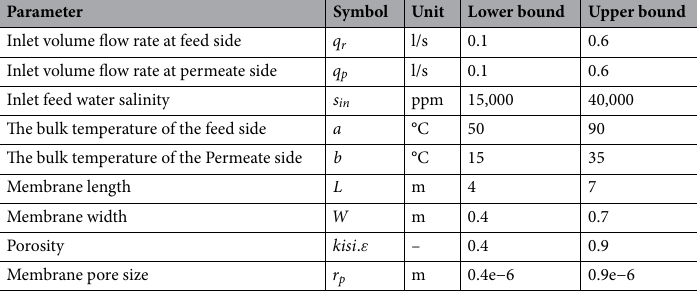
Table 2. Ranges of decision variables in the present study.